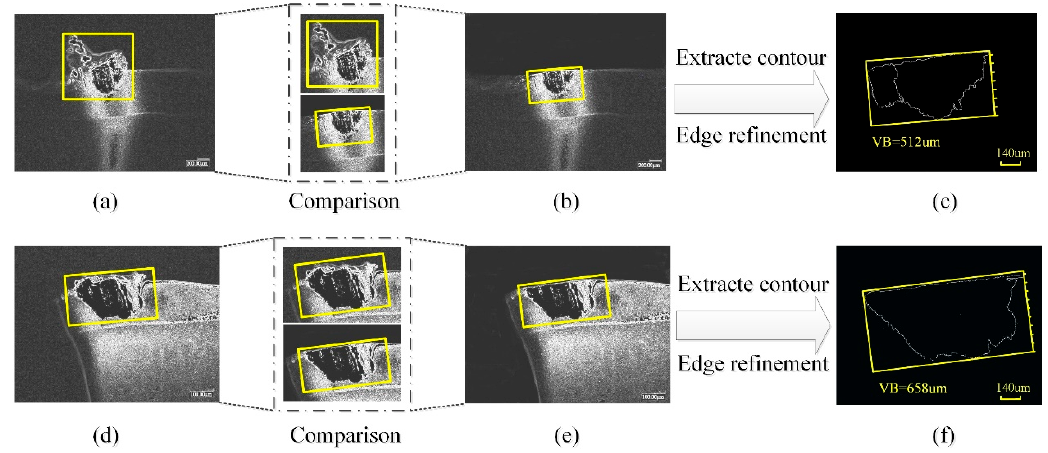
Figure 5. Comparison of detection methods for the value of tool wear. ( a , d ) Roughly processed images of adhesive wear and sheet peeling; ( b , e ) cropped images; ( c , f ) edge refined images.